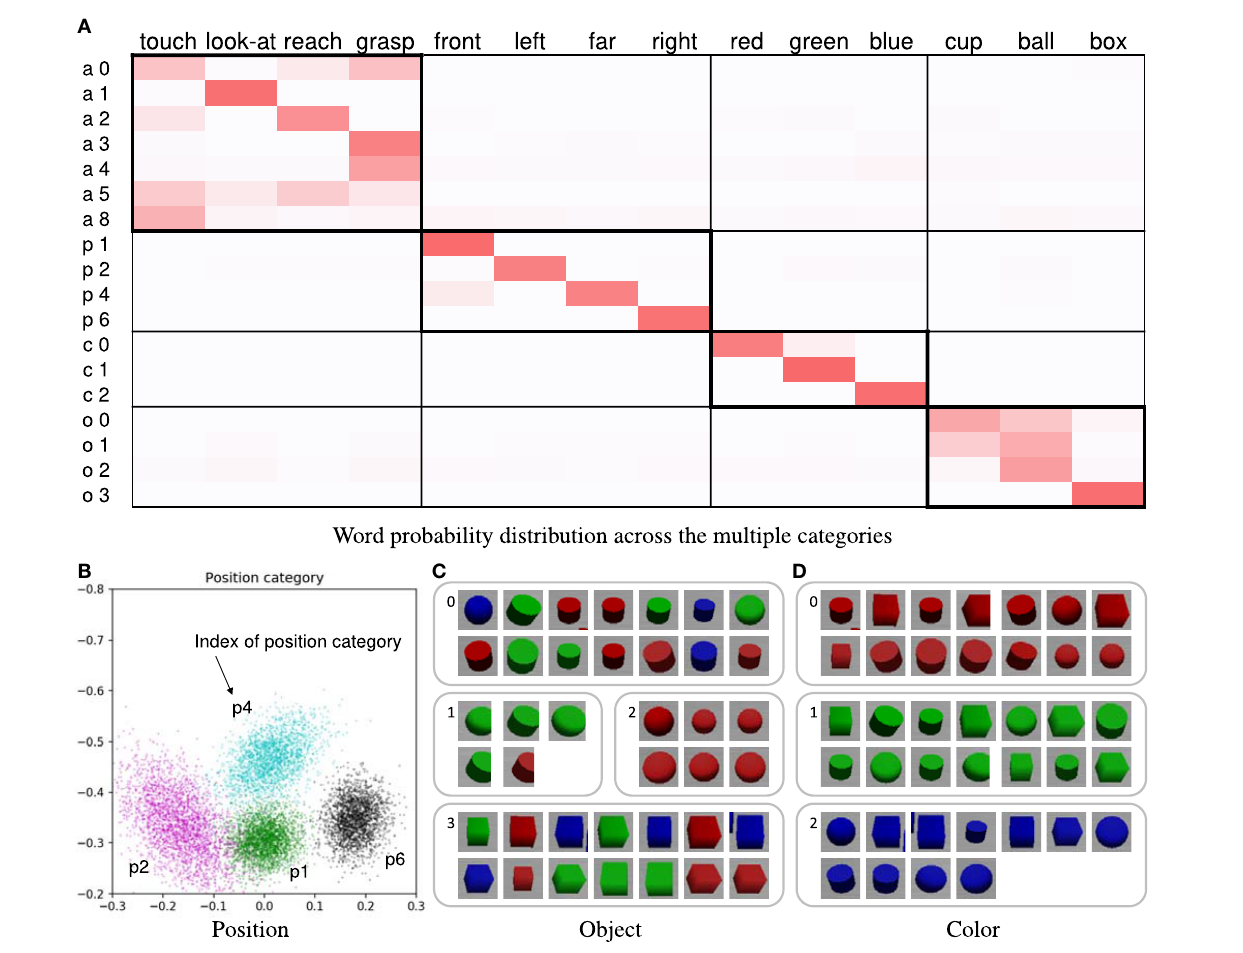
FIGURE 4 | (A) Word probability distribution across the multiple categories; darker shades represent higher probability values. The pair consisting of a letter and a number on the left of the table is the index of the word distribution, which represents the sensory-channel related to the word distribution and the index of the category. Note that category indices are not shown; they are merged and not used because the number of the categories is automatically estimated by the nonparametric Bayesian method. (B) Learning result of the position category; for example, the index of position category p1 corresponds to the word “front.” The point group of each color represents each Gaussian distribution of the position category. The crosses in the different colors represent the object positions of the learning data. Each color represents a position category. (C) Example of categorization results of object category; (D) example of categorization results of color